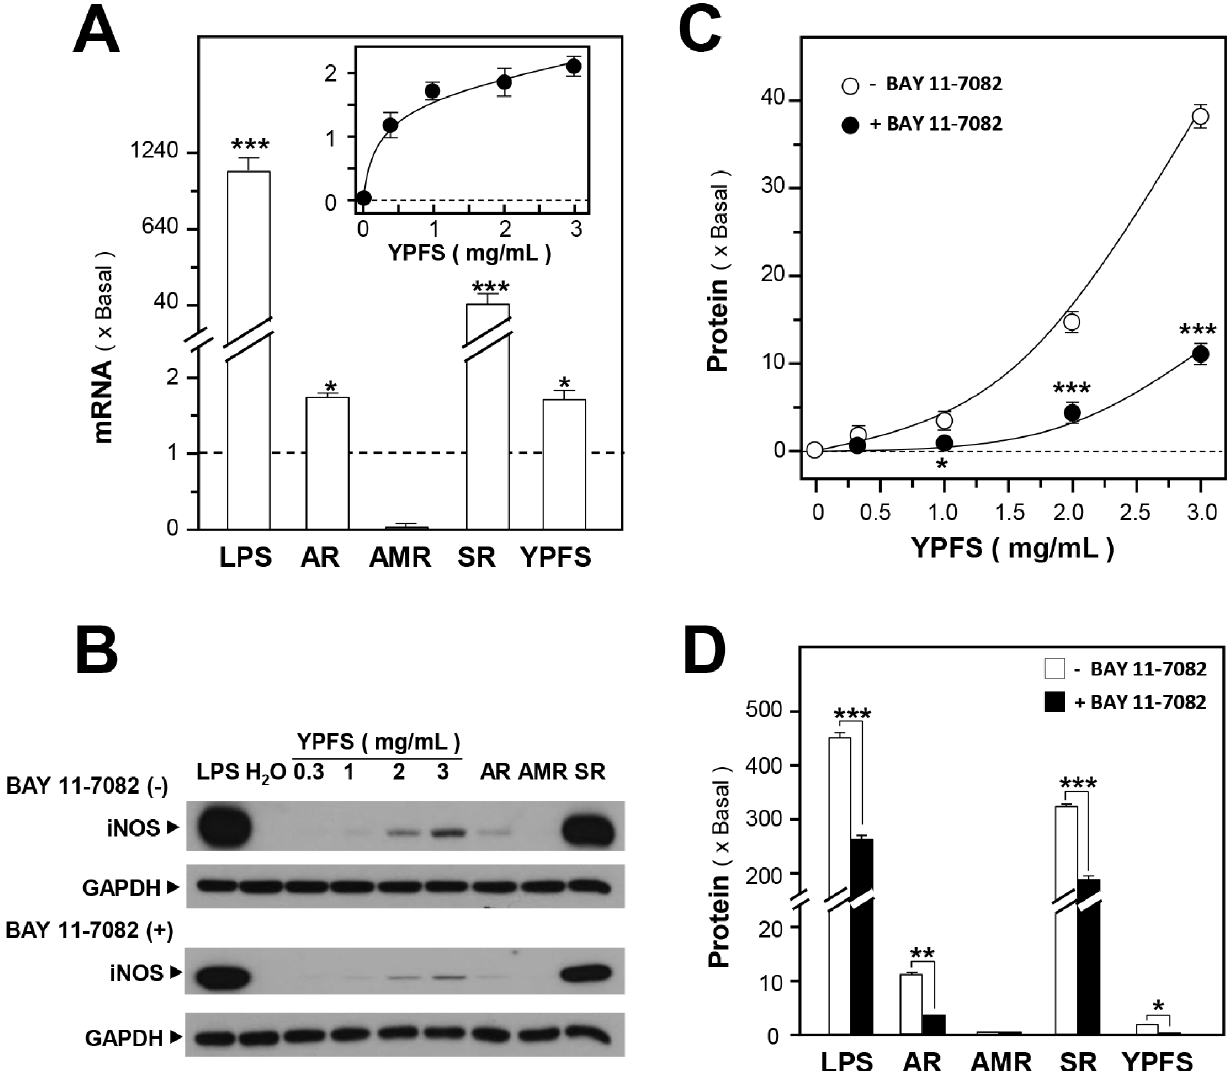
Figure 4. YPFS induces iNOS expression in macrophages. ( A ): Cultured macrophages were treated with 1 mg/mL of the single herbal extracts and YPFS (inset) for 24 hours, and then the expression of iNOS was determined using RT-PCR, with GAPDH serving as the internal control. LPS (1 m g/ mL) was used the positive control. ( B ): Effects of herbal extracts on the expression of iNOS protein in cultured macrophages in the presence and absence of the NF- k B-specific inhibitor BAY 11-7082 (5 m M). ( C ): Macrophages were treated with YPFS for 24 hours after first incubating the cells for 3 hours with or without the NF- k B inhibitor BAY 11-7082 (5 m M). Cell lysates were collected, diluted to equal protein concentrations, and analyzed by means of western blotting. ( D ): Macrophages were treated with 1 mg/mL of the individual herbs (AR, AMR, and SR) for 24 hours after first incubating the cells with or without BAY 11-7082 (5 m M) for 3 hours. Results in (C) and (D) were calculated using the western blots shown in (B). Values were normalized using the internal control GAPDH and are expressed as fold-increases relative to basal reading (untreated cultures); mean 6 SD are shown, n =5, each with triplicate samples. * p , 0.05; ** p , 0.01; *** p , 0.001.